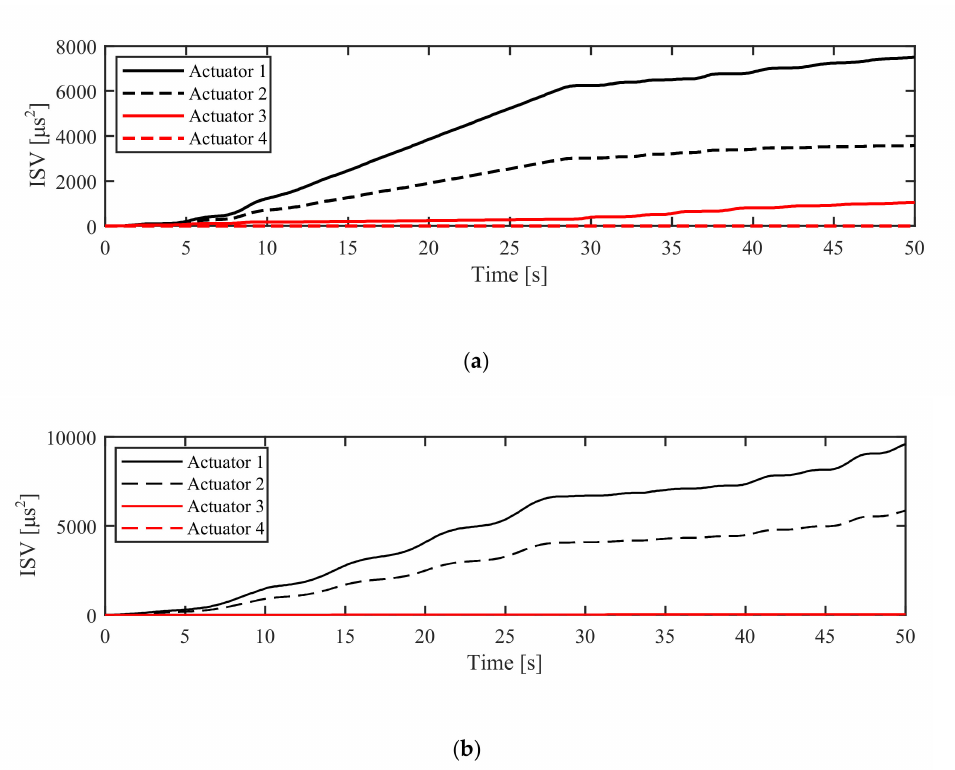
Figure 17. The performance indices in AM mode: ( a ) ISV values of the proposed controller; ( b ) ISV values of the